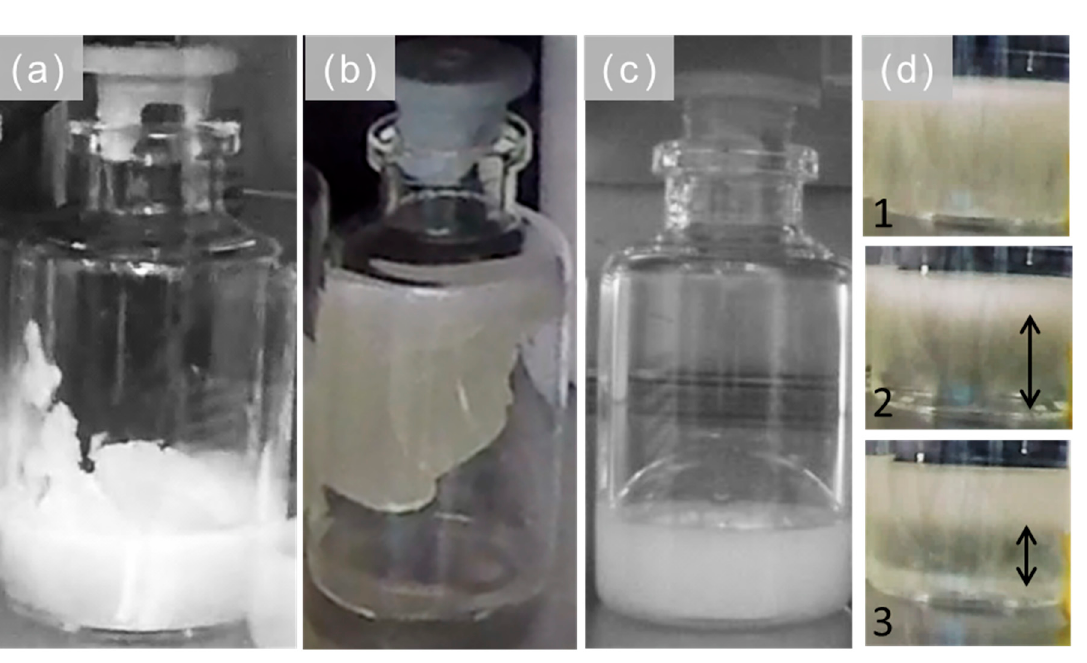
Figure 1. Challenges during cycle optimization using controlled nucleation parameters. ( a ) Boiling, ( b ) depositioning of the cake, ( c ) skin formation, and ( d ) liquefaction over time, as indicated by the black arrows.